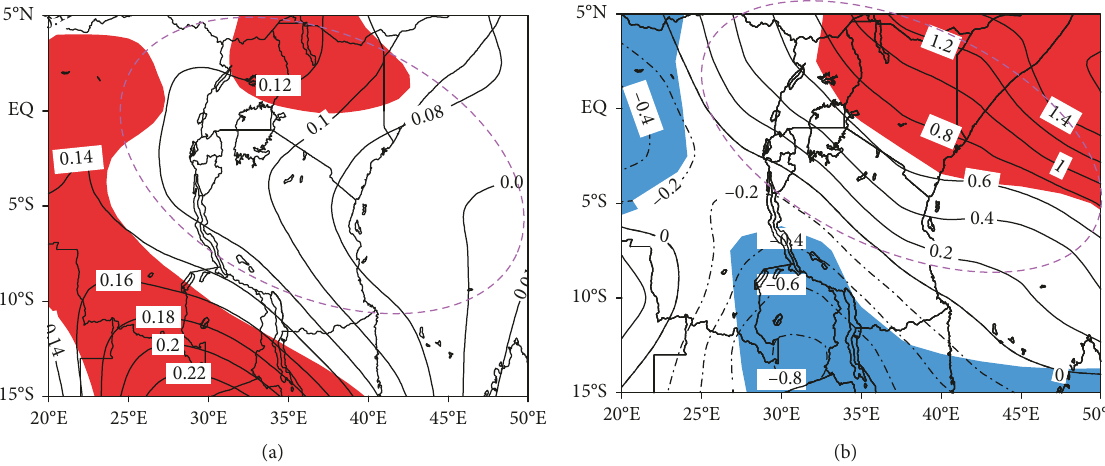
Figure 11: (a) 600–300hPa average layer temperature anomalies (contour interval 0.02 ° C) and (b) the difference in zonal wind anomalies between 600 and 300hPa levels (contour interval 0.2 ms level. 5 ° N